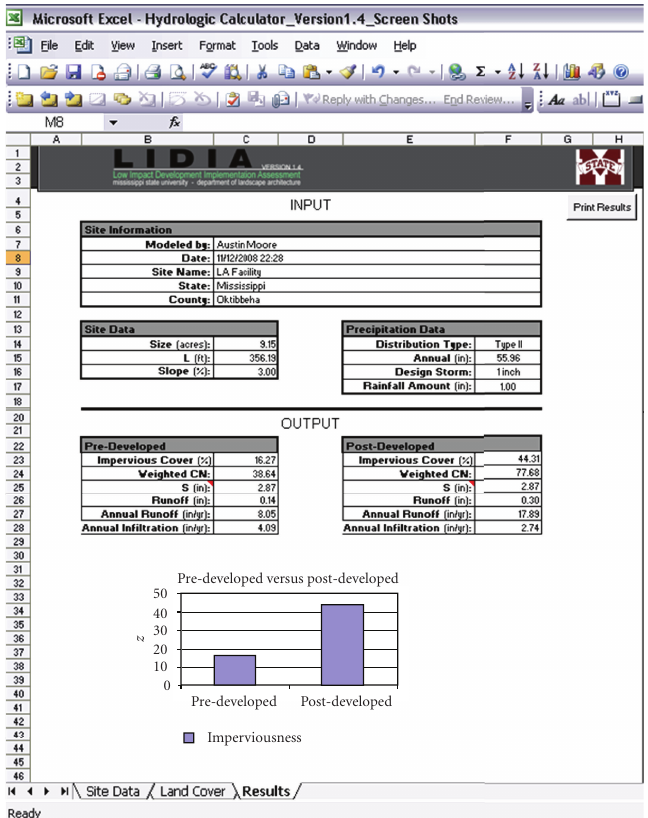
Figure 18: Latis-LIDIA Model Output